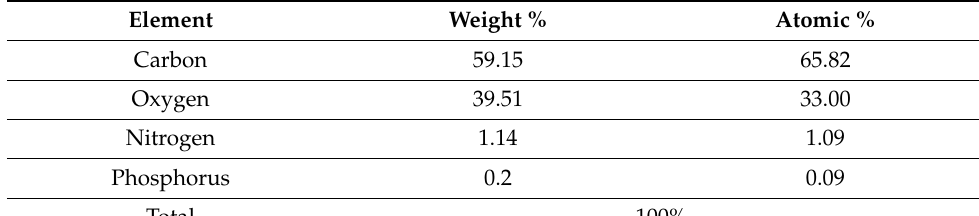
Table 4. Elemental composition of H6-SNP.